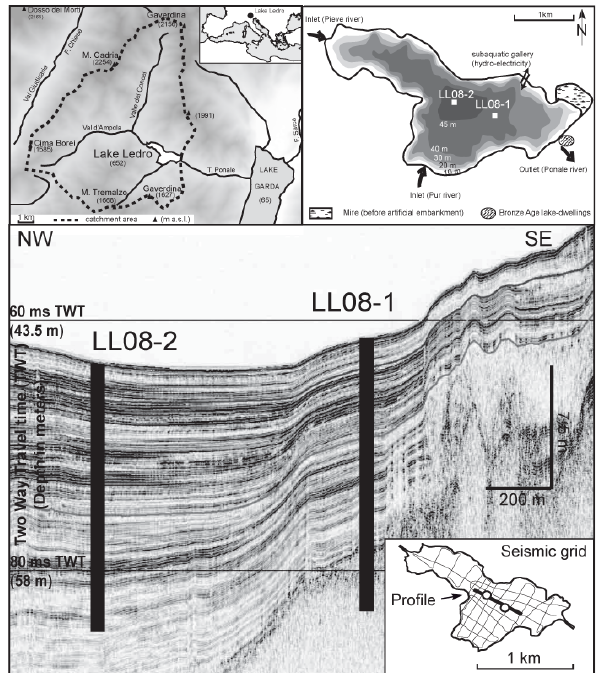
Fig. 1a. Location of Lake Ledro (Trentino, Italy) and its catchment (top-left panel); the bathymetry of the lake and positions of the cor- ing sites, inlets, outlet and archaeological site (top-right panel); a NW-SE seismic profile, with positions of cores LL08-2 and LL08-1 (bottom